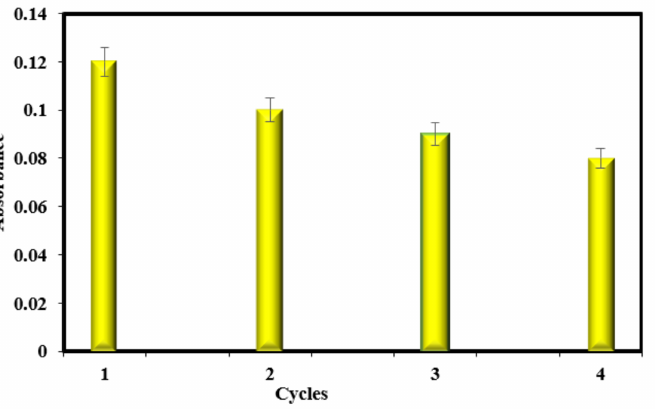
Figure 7. Recyclability test with repeated cycles (pH = 3.0 at 25 ◦ C, and 0.5 mL H 2 O 2